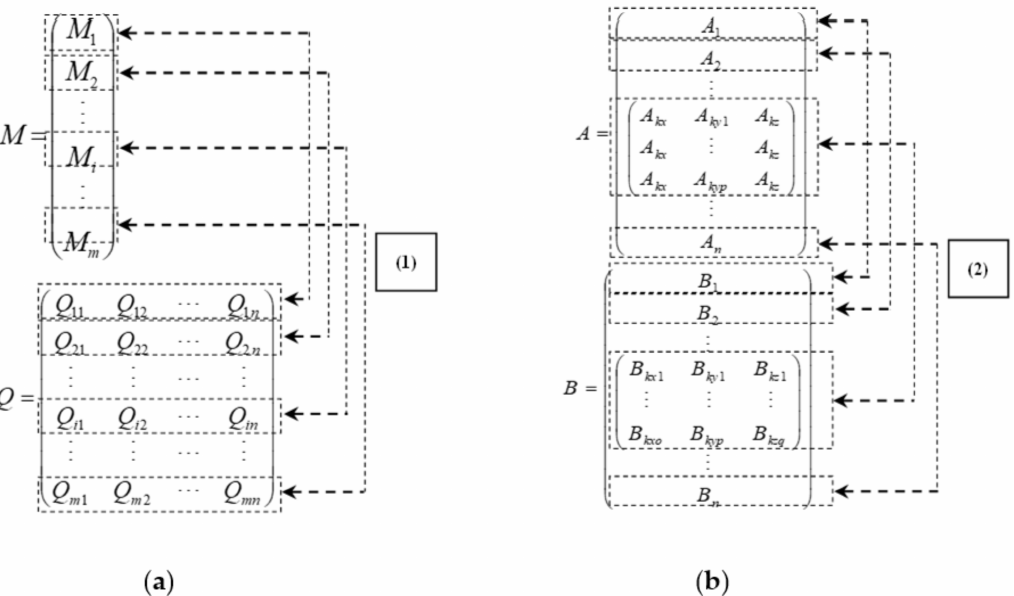
Figure 4. ( a ) Digital expression model of the plug interface; matrix M represents the location of components and matrix Q represents the connection section of components; ( b ) Digital expression model of socket interface; matrix A represents the interface location and matrix B represents the acceptable